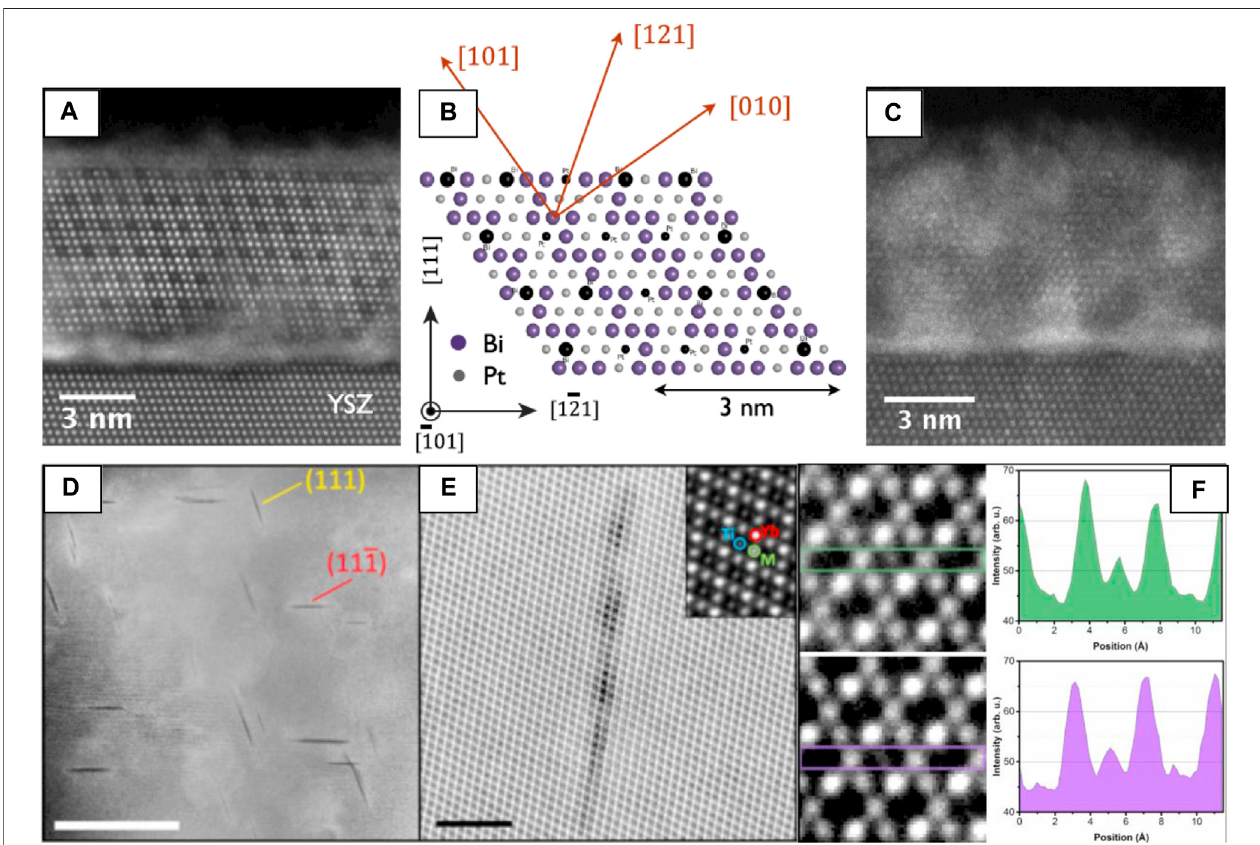
FIGURE 6 | HAADF-STEM imaging showing cation (A – C) vacancies and (d – f) anti-site defects. (a) HAADF-STEM image of ordered Bi 2 Pt 2 O 7 [101] epitaxial pyrochlore in the annealed bismuth-rich fi lm. Dark, ordered atomic positions in the image indicate the presence of ordered cation vacancies. (B) Atomic model of the Bi 2 Pt 2 O 7 [101] pyrochlore, where black positions denote cation vacancies, as seen in the image in (A) . (C) HAADF-STEM image of Bi 2 Pt 2 O 7 [101] without cation vacancies. Reproduced from reference (Gutiérrez – Llorente et al., 2015) (D) ADF-STEM image of planar defects in Yb 2 Ti 2.05 O 7 [110] irradiated with 200 keV electrons. (E) Magni fi ed strain-free defect. (F) anomalously bright Ti columns on defect edges. Reproduced from reference (Mostaed et al., 2018).